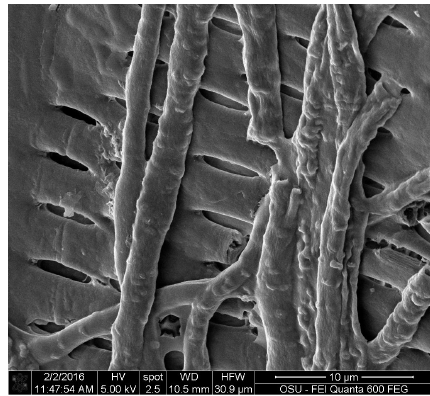
Figure 3. S. cuboideum hyphae developing across the vessel pits.